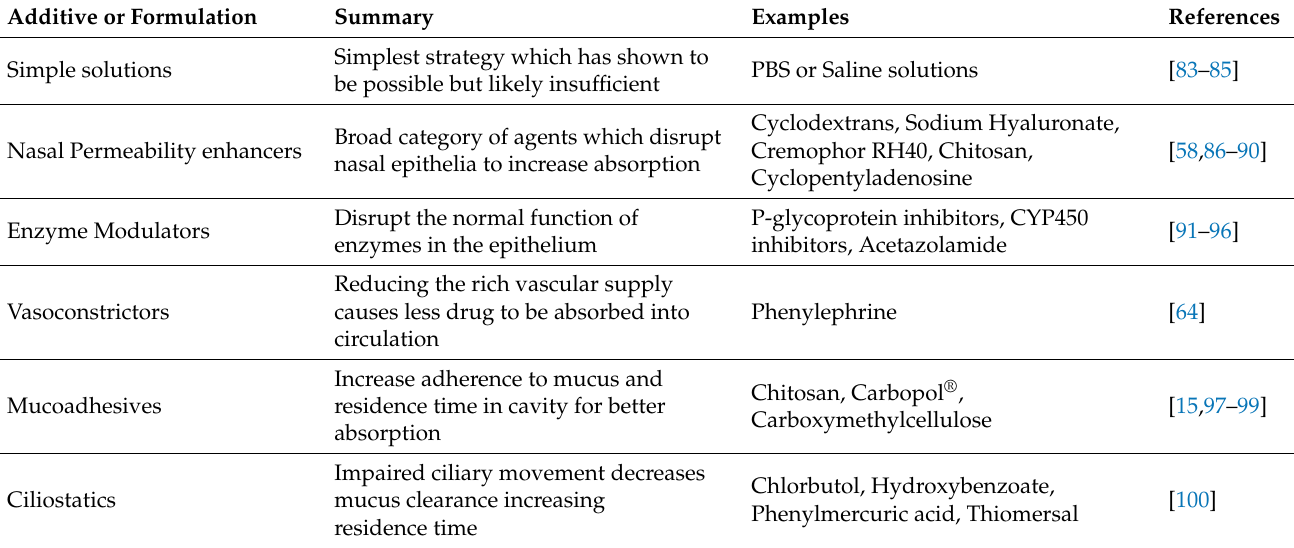
Table 2. Notable additives and strategies for intranasal delivery